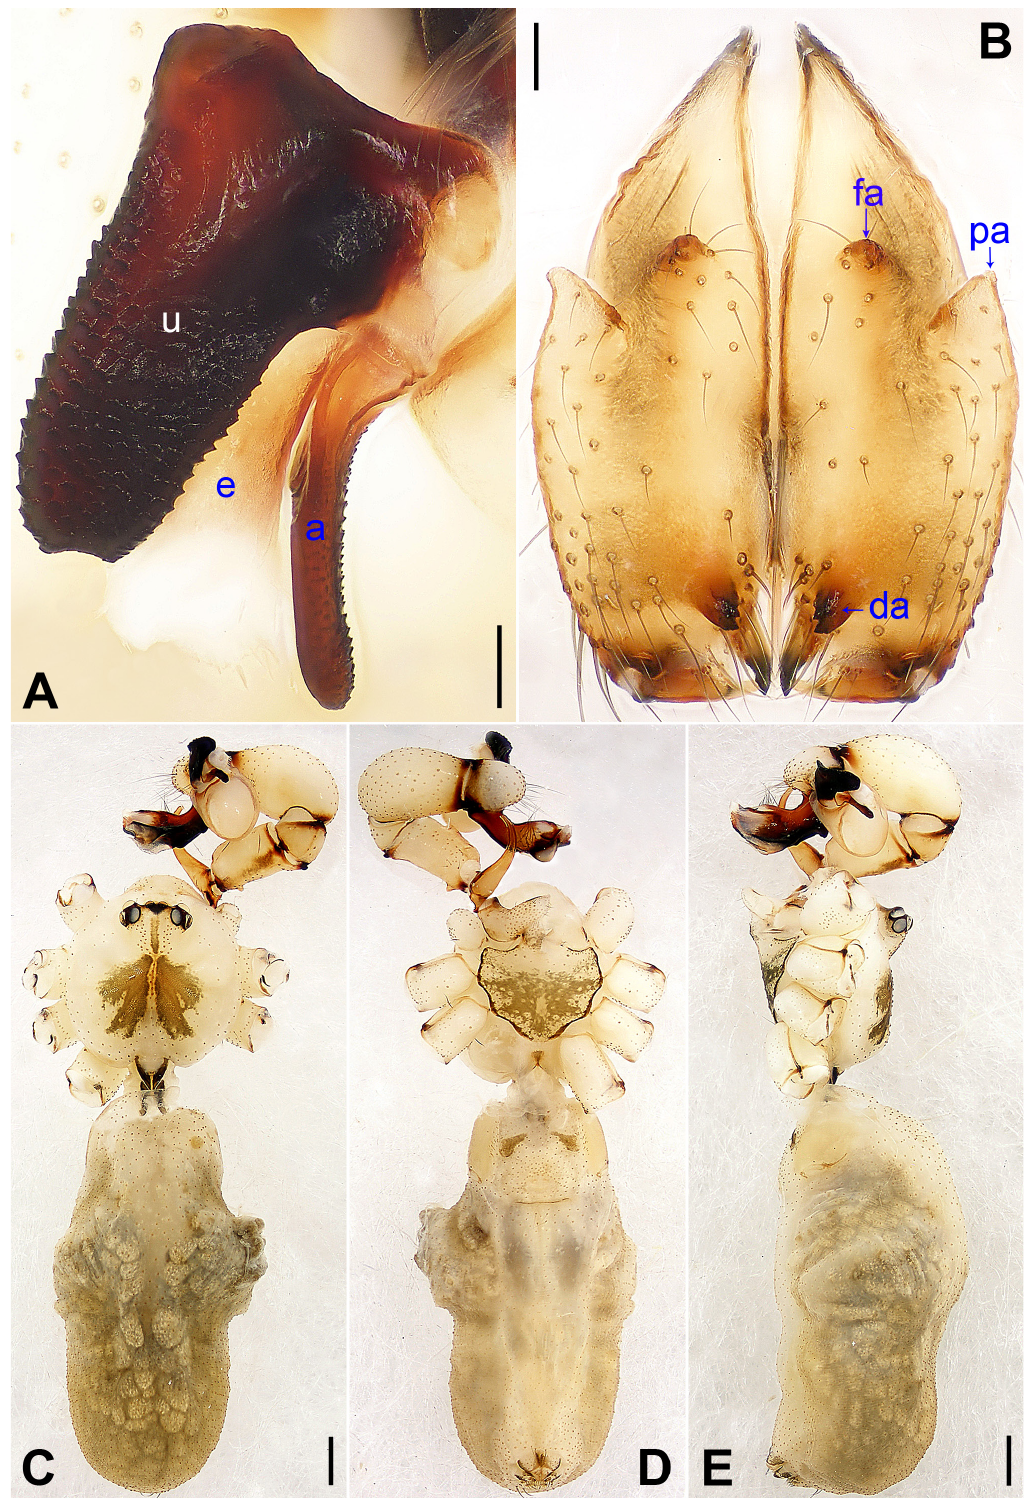
Fig. 4. Pholcus shuguanensis Yao & Li sp. nov., holotype, ♂. A . Bulbal apophyses, prolateral view. B . Chelicerae, frontal view. C–E . Habitus (C. Dorsal view. D. Ventral view. E. Lateral view). Abbreviations: a = appendix; da = distal apophysis; e = embolus; fa = frontal apophysis; pa = proximo- lateral apophysis; u = uncus. Scale bars: A–B = 0.10 mm; C–E = 0.50